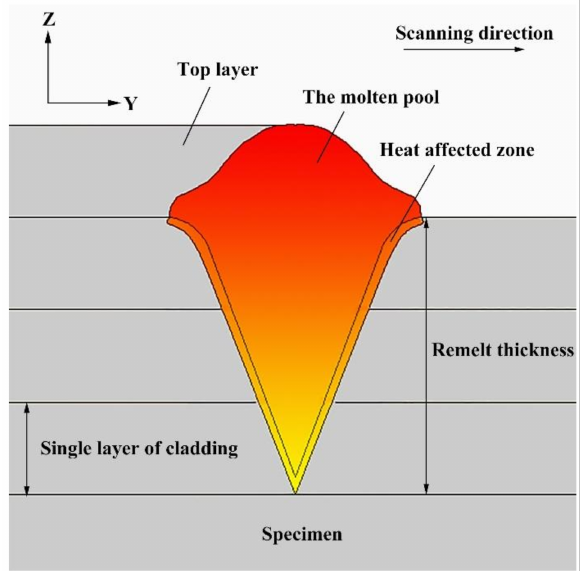
Figure 6. A schematic diagram of the remelting